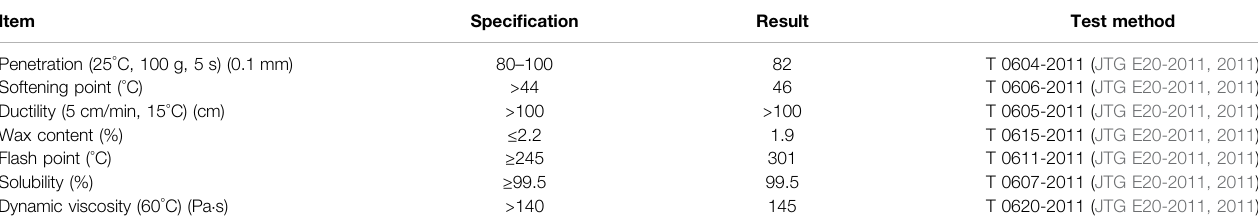
TABLE 1 | Technical properties of matrix asphalt. Item Speci fi cation